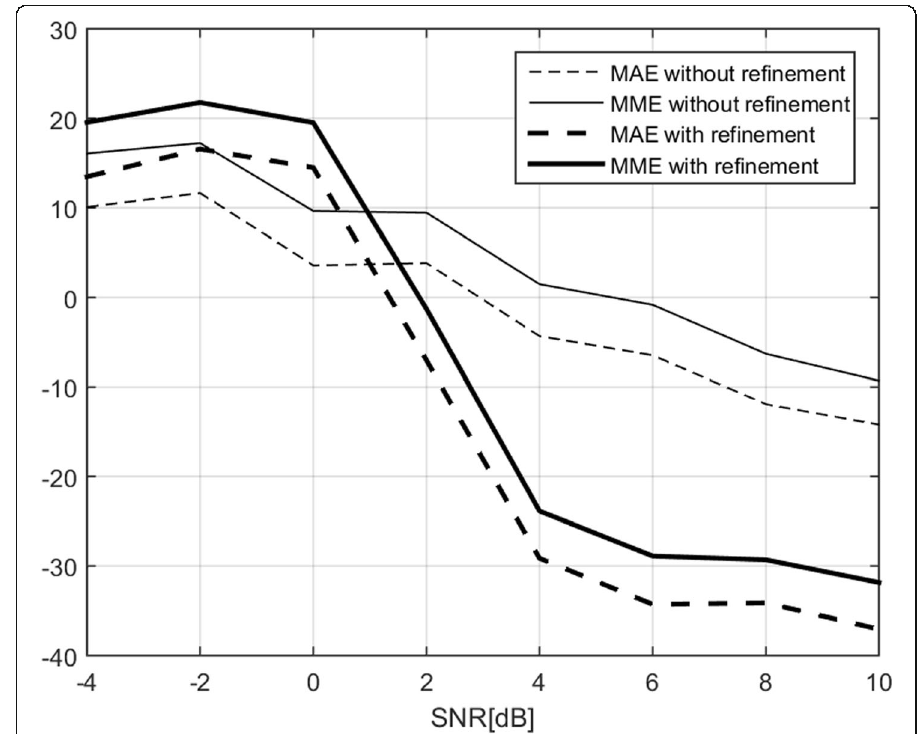
Fig. 10 Statistics (MAE — dashed lines, MME — solid lines; thin lines — without refinement; thick line — with refinement) for the RANSAC application to the noisy cubic phase signal with K / N =12% in the Gaussian noise environment vs. the